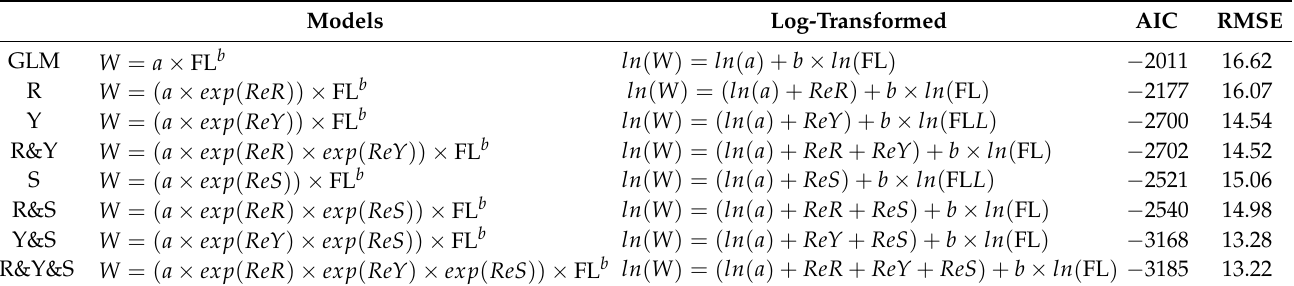
Table 2. Fork Length-weight relationship of Chub mackerel and its fitting effects. Notes : R refers to the spatial random effects with intercept ln( a ); Y refers to the random effect of years with intercept ln( a ); S refers to the random effect of seasons with intercept ln( a ).